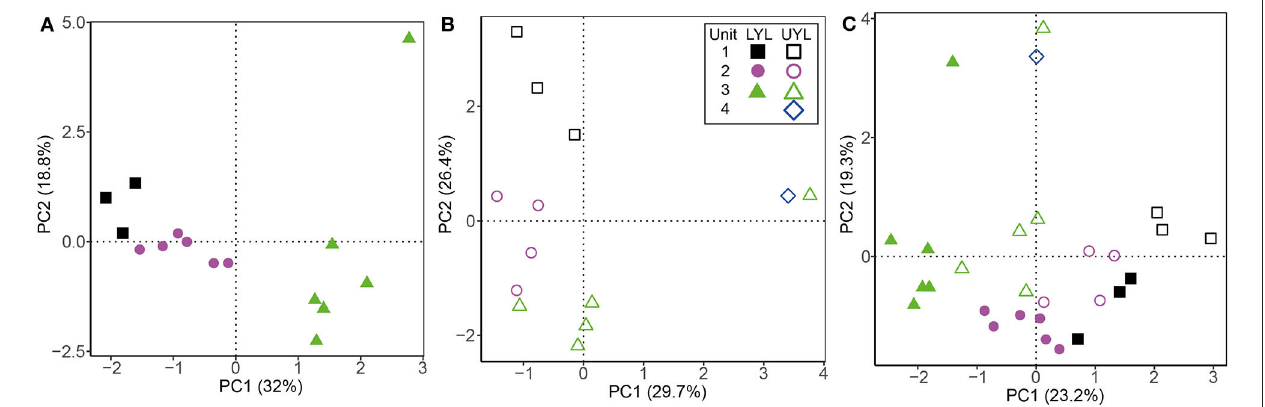
FIGURE 5 | Ordination plot for first and second axes of variance from PCA of the microbial community composition in LYL on class level. (A) LYL (filled shapes), (B) UYL (hollow shapes), and (C) YL. Unit 1: black squares; unit 2: purple circles; unit 3: green triangles; unit 4: blue diamonds. Axis labels denote percentage of total variance explained by the respective principal components (PCs).